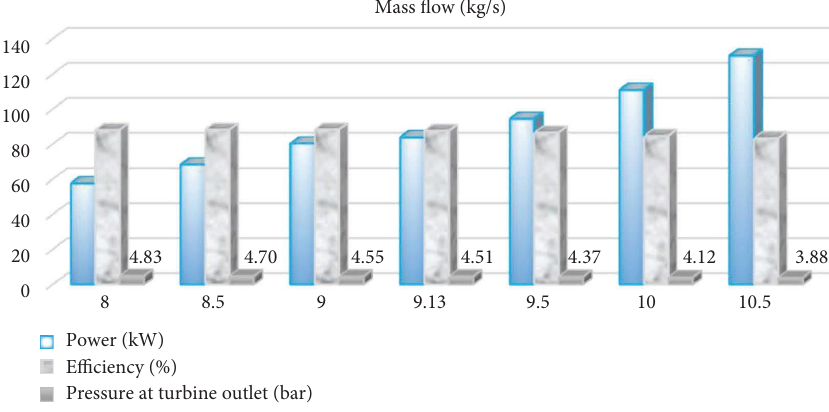
Figure 14: Te infuence of mass fow rate.